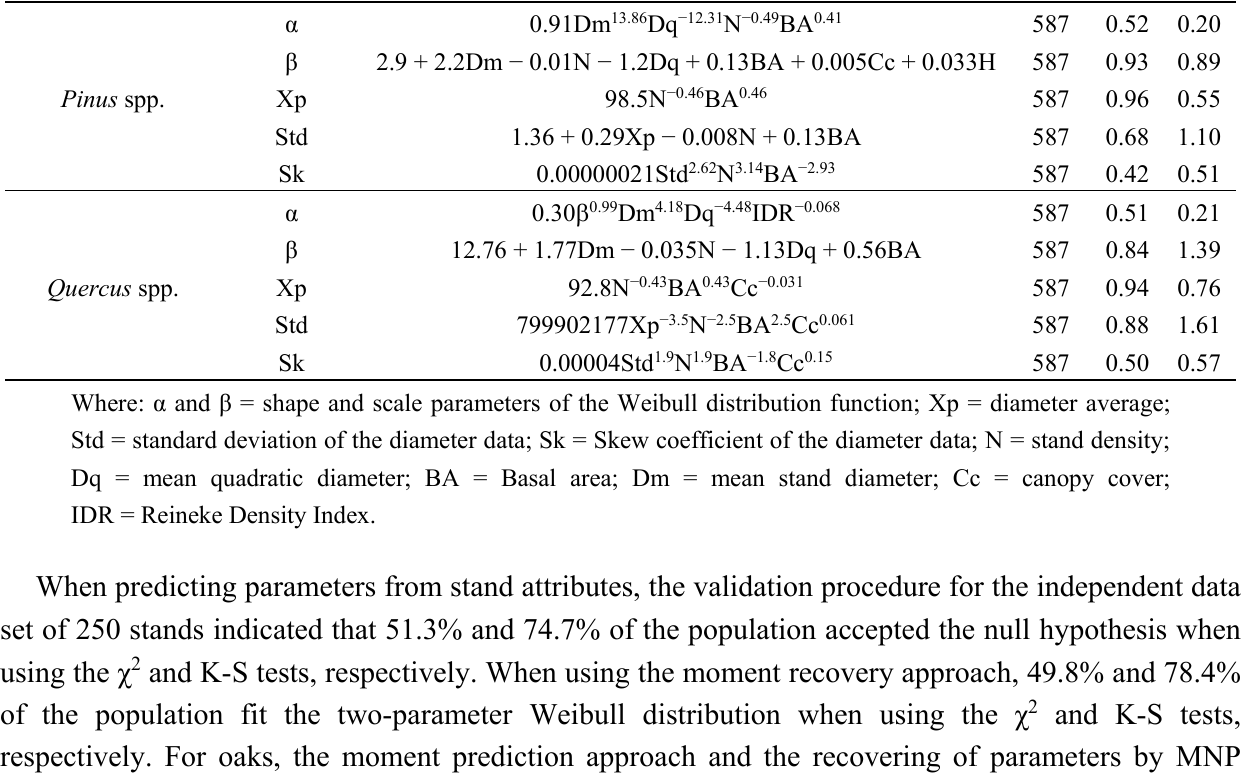
Table 4. Weibull parameter prediction and recovery equations for pine and oaks growing in Mexico’s northern mixed multiaged temperate forests. Group of Species Parameter Empirical Equation n r 2